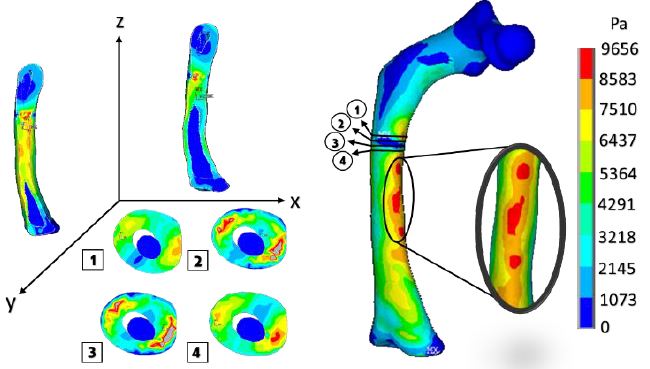
Figure 18. Isotropic analysis of the transverse fracture case. Von Mises stress showing maximum stress of 9.656 Pa.